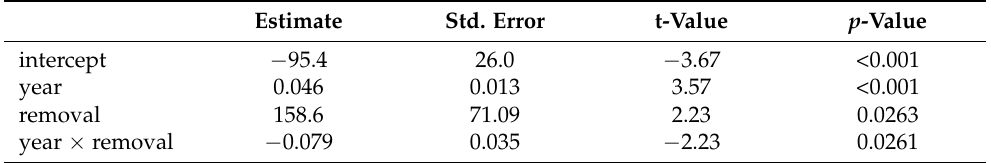
Table 2. Results from ANOVA of spruce budworm E/M ratio 1997 – 2011, against year and forest removal rate, excluding years of potentially heavy immigration from afar: 1999, 2000, and 2009.